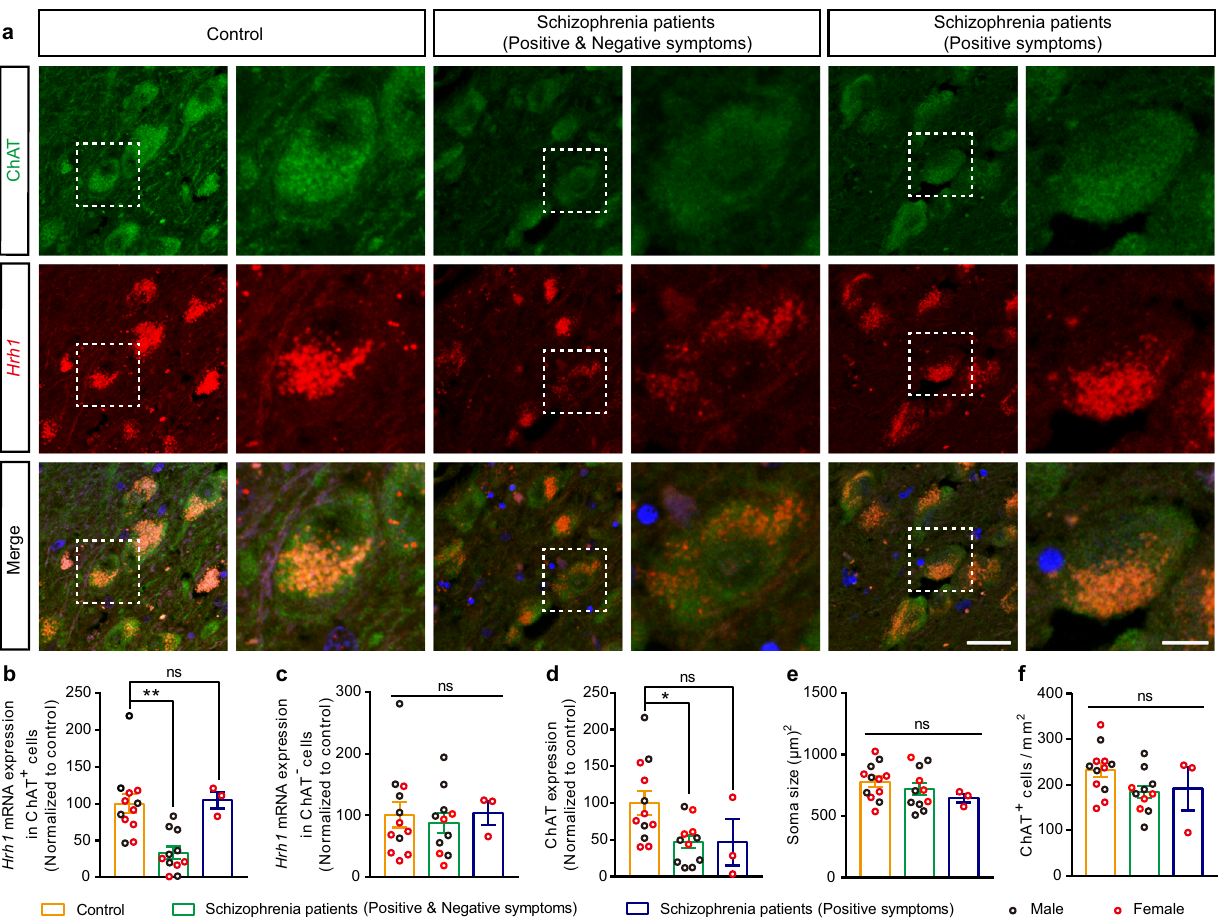
Fig. 1 Decreased histamine H 1 R expression in BF cholinergic neurons in patients with schizophrenia having negative symptoms. a Representative images of RNAscope in situ hybridization of Hrh1 mRNA together with immunostaining of choline acetyltransferase (ChAT) in the NBM of BF for patients with schizophrenia and controls. The right panels are enlarged from the dotted box in the left panels. Left: scale bar, 30 μ m. Right: scale bar, 10 μ m. b – f Hrh1 mRNA expression in ChAT + or ChAT − cells, ChAT expression, soma size, and density of ChAT + cells in patients with schizophrenia and controls ( n = 12 for controls, n = 11 for patients with schizophrenia having positive and negative symptoms, and n = 3 for patients with schizophrenia having positive symptoms). b Quantitative analysis of Hrh1 mRNA expression in ChAT + cells of patients with schizophrenia and controls. c Quantitative analysis of Hrh1 mRNA expression in ChAT - cells of patients with schizophrenia and controls. d Quantitative analysis of ChAT expression of ChAT + cells in patients with schizophrenia and controls. e Quantitative analysis of soma size of ChAT + cells in patients with schizophrenia and controls. f Quantitative analysis of density of ChAT + cells in patients with schizophrenia and controls. All data are presented as mean ± s.e.m. and error bars represent s.e.m. *P ≤ 0.05, **P ≤ 0.01, ns nonsigni fi cant. See also Supplementary Data 2 for further statistical information. Source data are provided as a Source Data fi